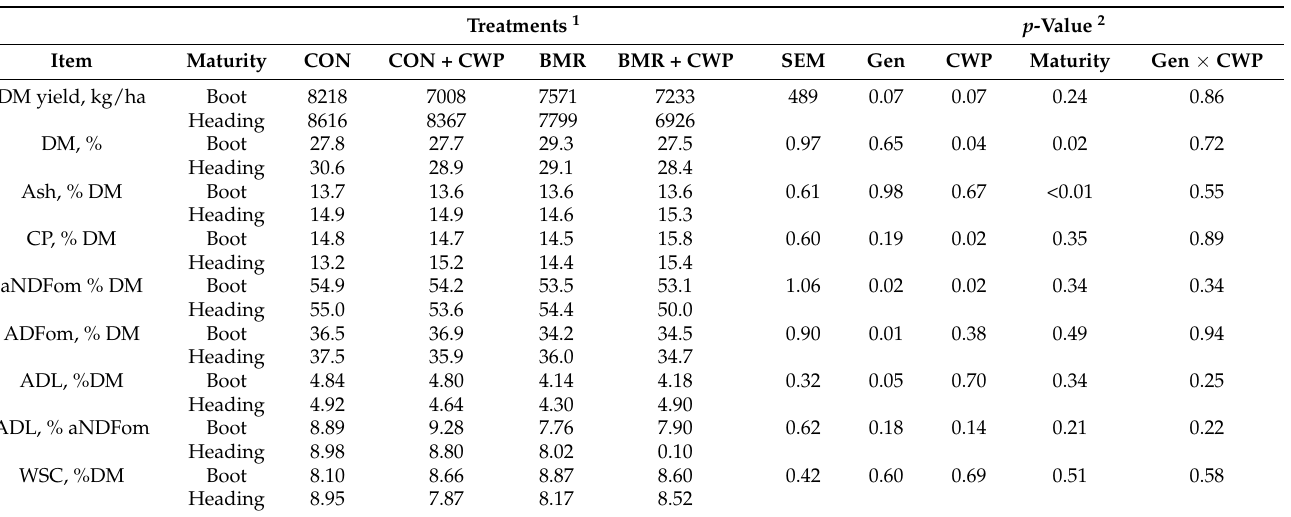
Figure 3. Potentially digestible NDF (pdNDF) yield per ha for Trial 1. Gen ( p = 0.75), planting date ( p < 0.01), and Gen × planting date ( p = 0.52); vertical bars indicate standard errors of the mean. Table 3. Yield and nutritional composition of pearl millet genotypes mixed or not with cowpea harvested at boot or heading maturity stages (Trial